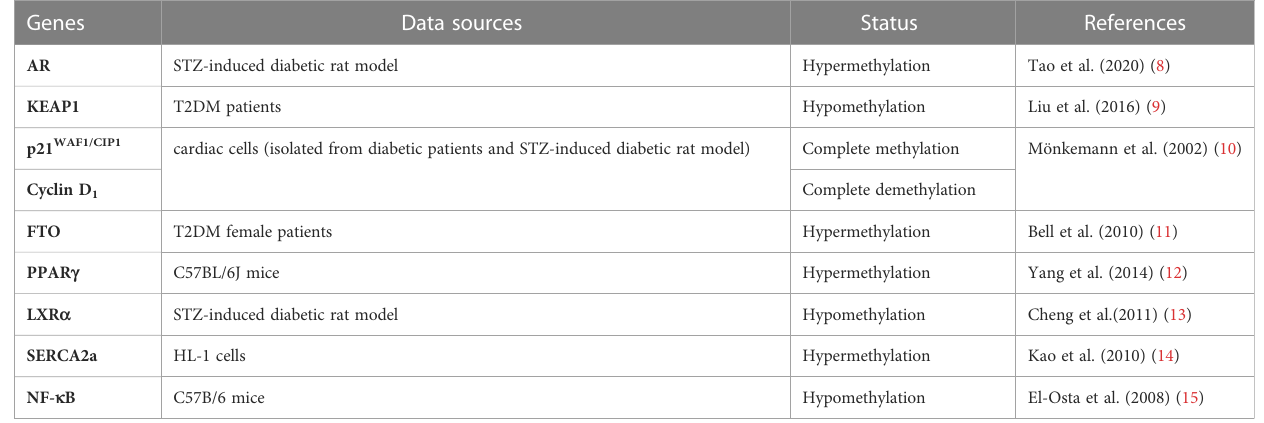
TABLE 1 Summary of studies focusing on DNA and histone methylation related to DCM.